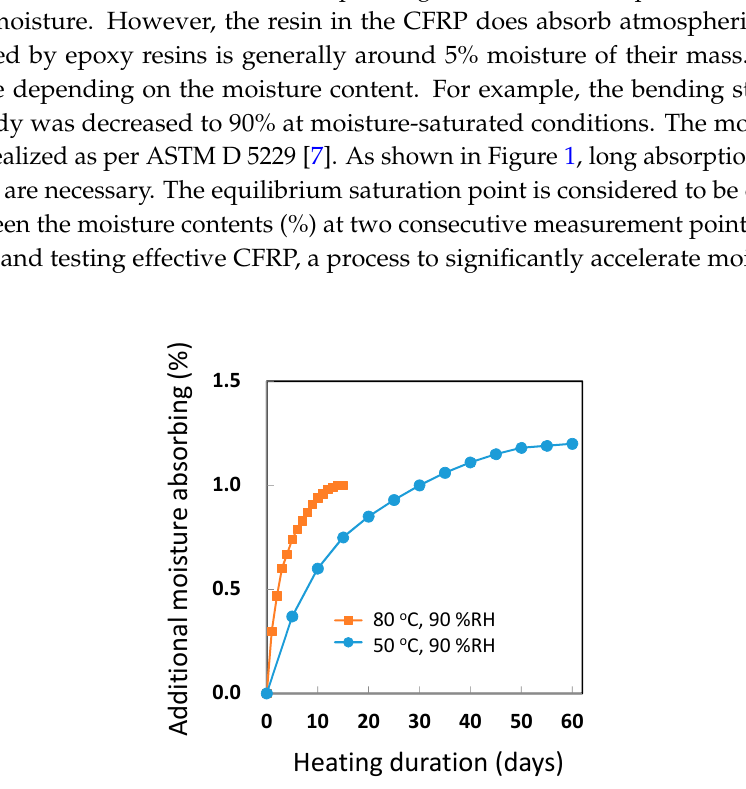
Figure 1. Moisture absorption by carbon fiber-reinforced plastics (CFRP) sample (1.5 mm thickness) at 50 °C and 90 percent relative humidity (% RH) and at 80 °C and 90% RH. Additional moisture absorbing is indicated as percentage to the total mass of non-dry CFRP samples.